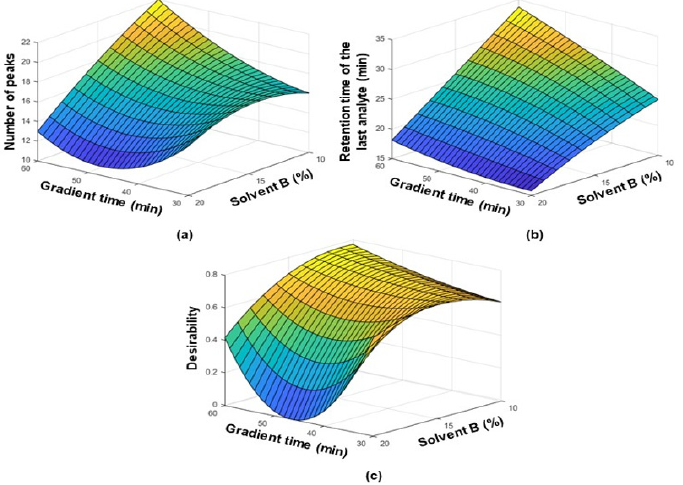
Figure 1. Optimization of the HILIC separation gradient by 2-factor at 3-level experimental design using a cranberry extract as a representative sample. Experimental factors and levels: Initial methanol percentage (10, 15 and 20% methanol) and gradient time (30, 45 and 60 min). Optimization criterion: Maximum number of resolved peaks on the fastest analysis. ( a ) Number of compounds resolved; ( b ) retention time of the last analyte peak and ( c ) effect of initial methanol percentage and gradient time on the separation of flavanol-related components expressed as a desirability function.